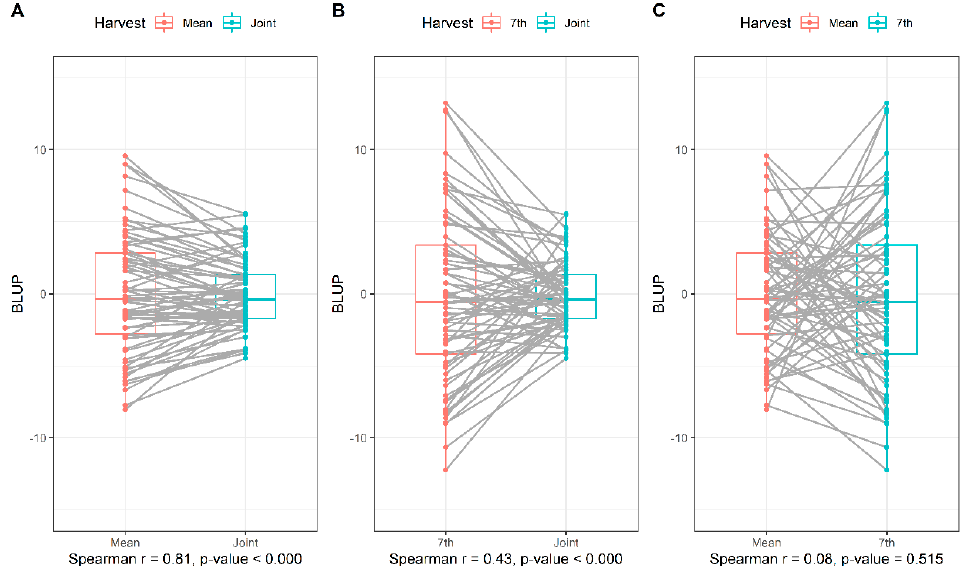
Figure 2. Spearman correlation between predicted genetic values (BLUPs) under different strategies for evaluating the productivity of F 4:5 coffee progenies: ( A ) correlation between the mean of the seven harvests and the harvest × progeny interaction considering all seven harvests, ( B ) between the seventh harvest only and the harvest × progeny interaction considering all seven harvests, and ( C ) between the seventh harvest only and the mean of the seven harvests.